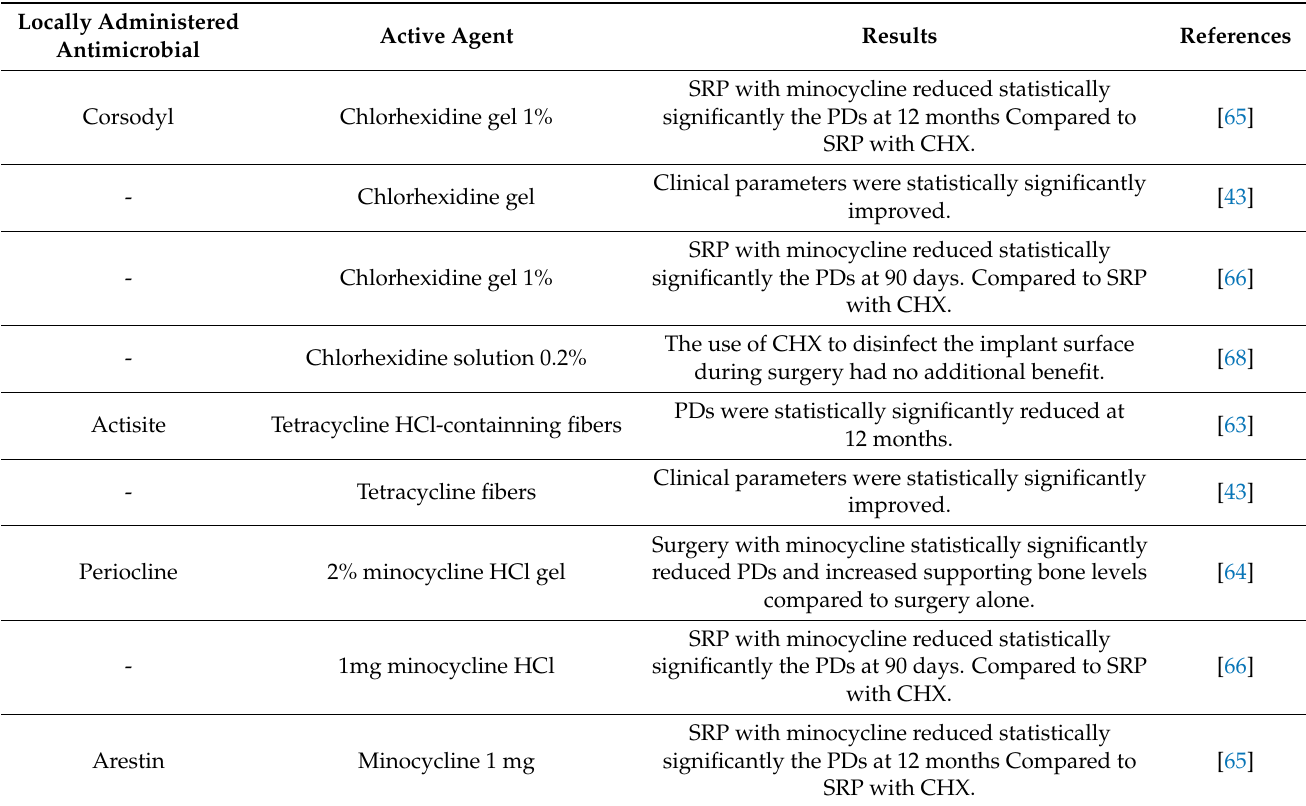
Table 2. Molecules used in local delivery for the treatment of